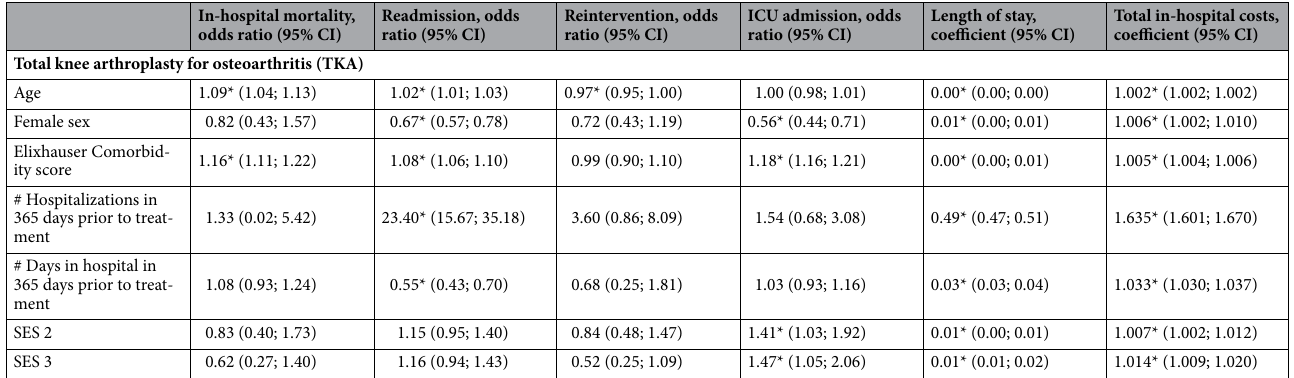
Table 6. Prognostic factors for outcomes and costs for knee osteoarthritis, where * p ≤